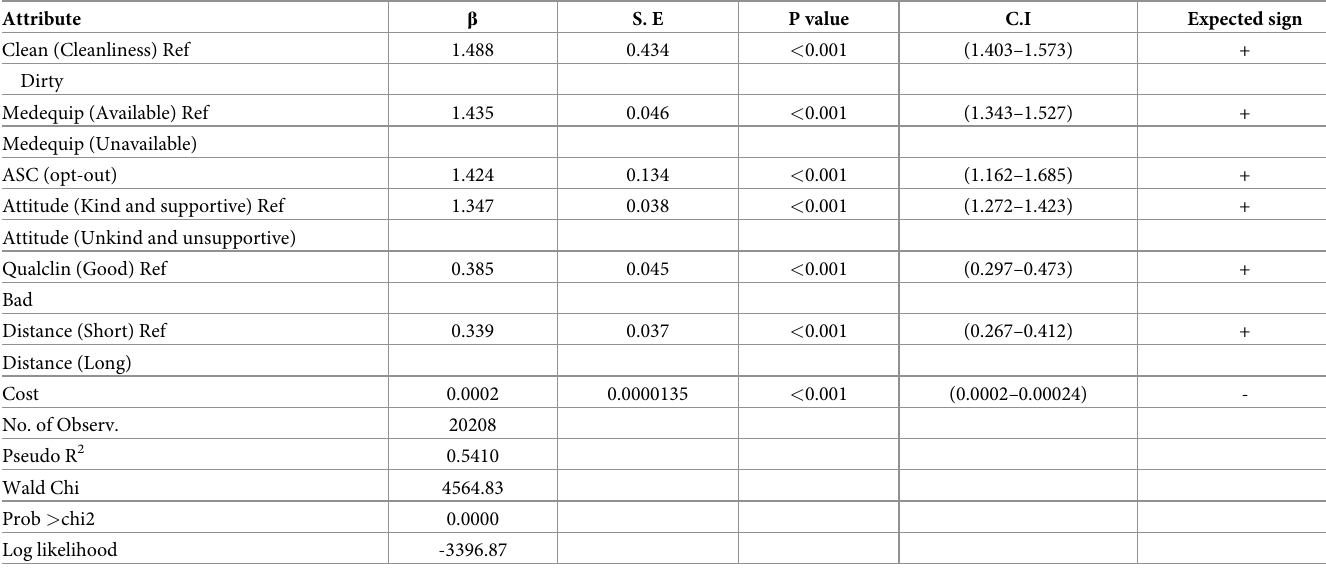
Table 4. Conditional Logit model for a discrete choice experiment assessing women’s preferences in a peri-urban setting in Kenya (N = 411). Attribute